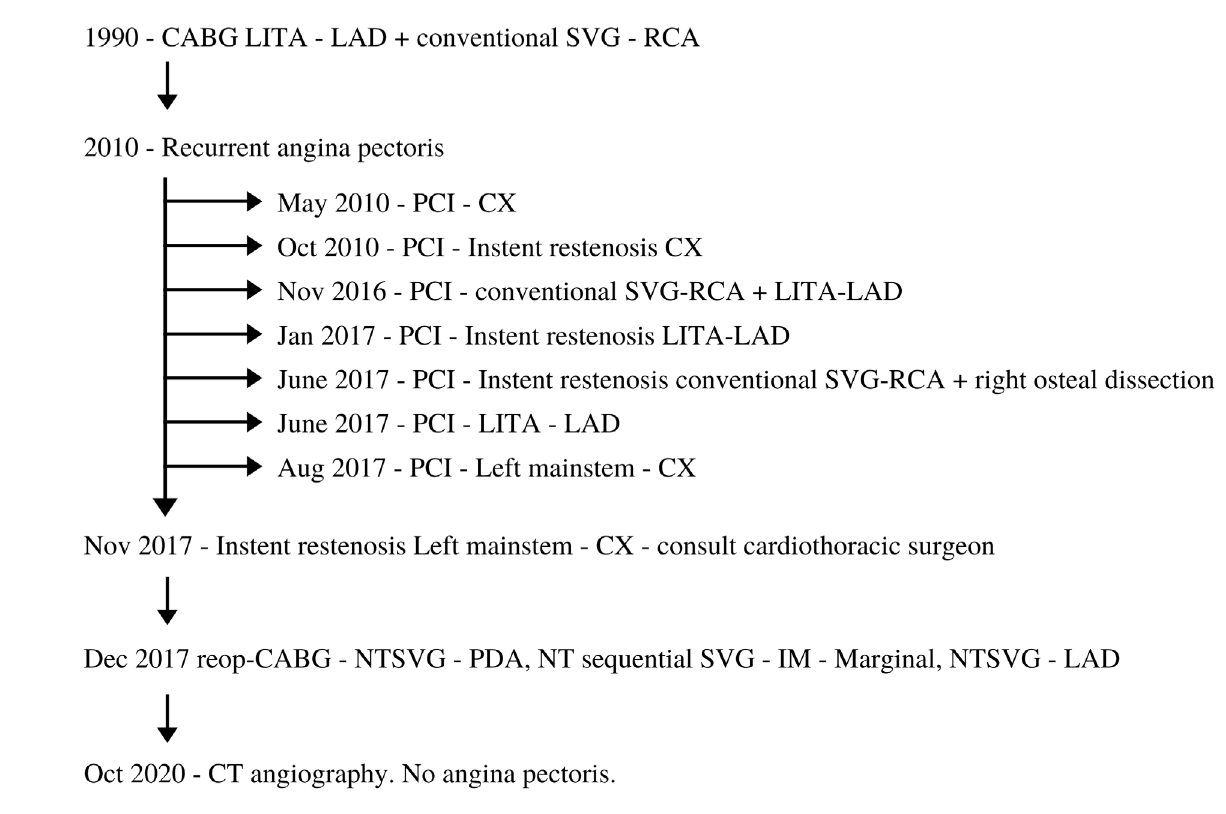
Fig. 1 - Flowchart of the revascularization treatment of the patient. CABG=coronary artery bypass graft; Cx=circumflex artery; LAD=left anterior descending artery; LITA=left internal thoracic artery; NT=no-touch; NTSVG=no-touch saphenous vein graft; PCI=percutaneous coronary intervention; RCA=right coronary